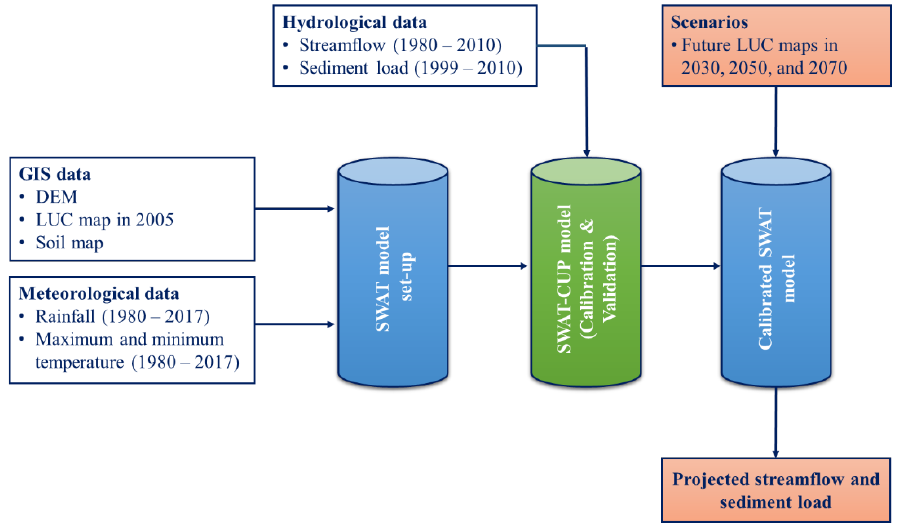
Figure 3. Framework of the hydrological modelling for the